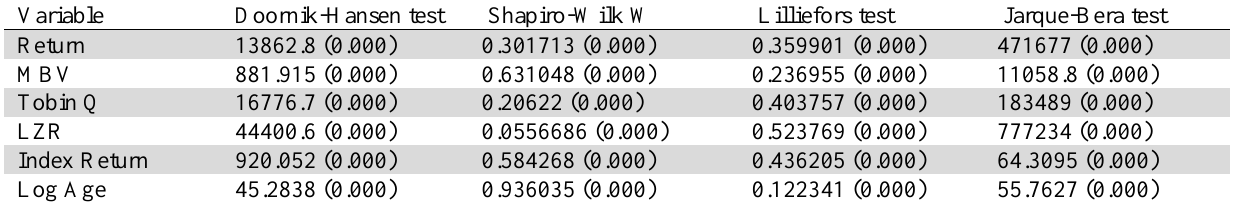
The results of the implementation of Doornik-Hansen, Shapiro-Wilk W, Lilliefors and Jarque-Bera test Variable